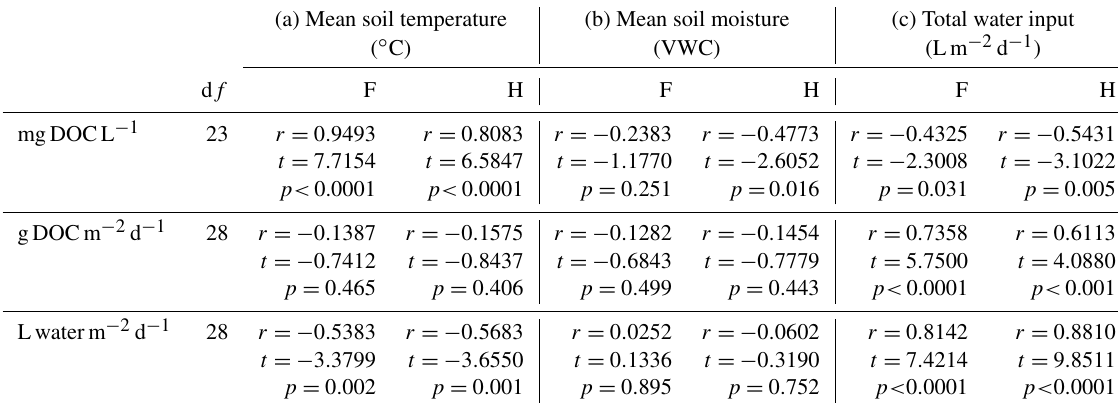
Table 2. Pearson correlations between lysimeter-captured dissolved organic carbon concentrations (mgDOCL − 1 ), dissolved organic carbon and daily water input rain and/or snowmelt) over 30 collection periods.